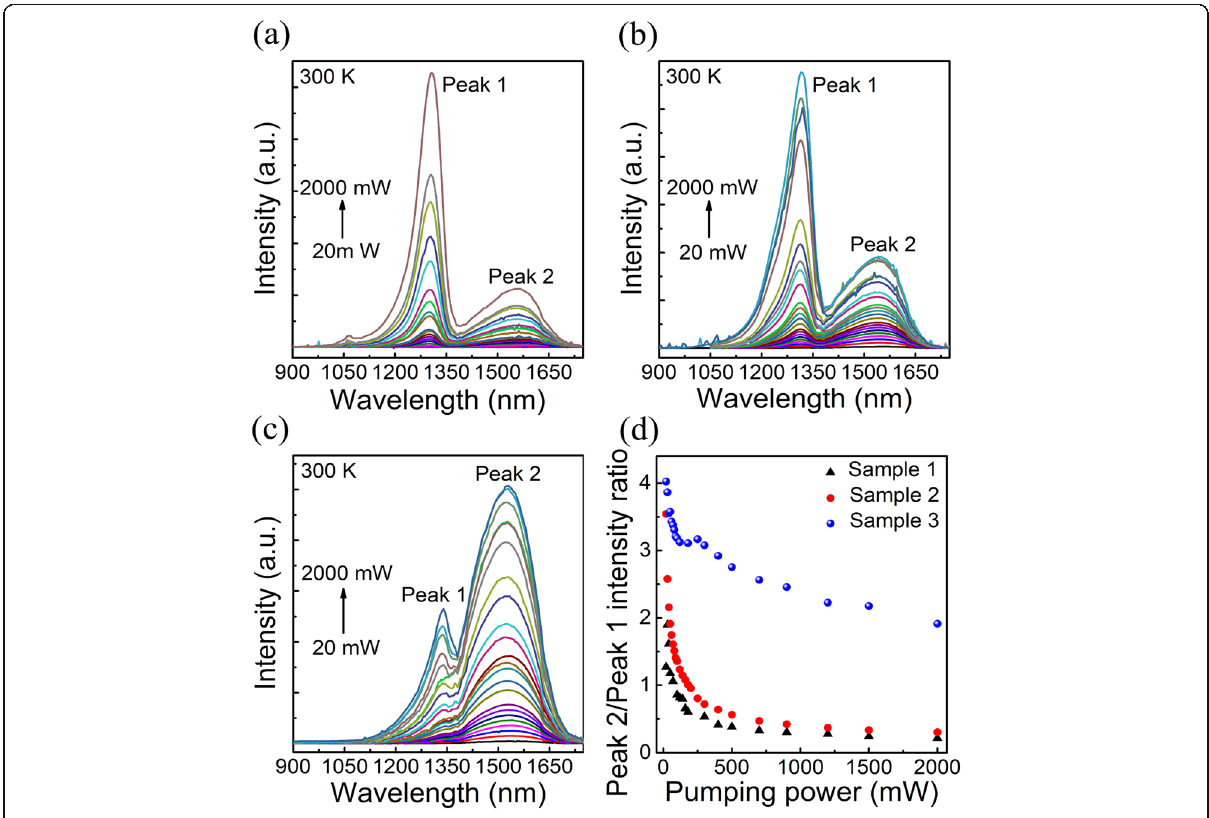
Fig. 3 Power dependent PL measurements. Room temperature power-dependent PL spectra measured at 20 – 2000 mW from a sample 1, b sample 2, and c sample 3, respectively. d Intensity radio of Peak 2/Peak 1 versus pumping power in samples 1, 2, and 3,